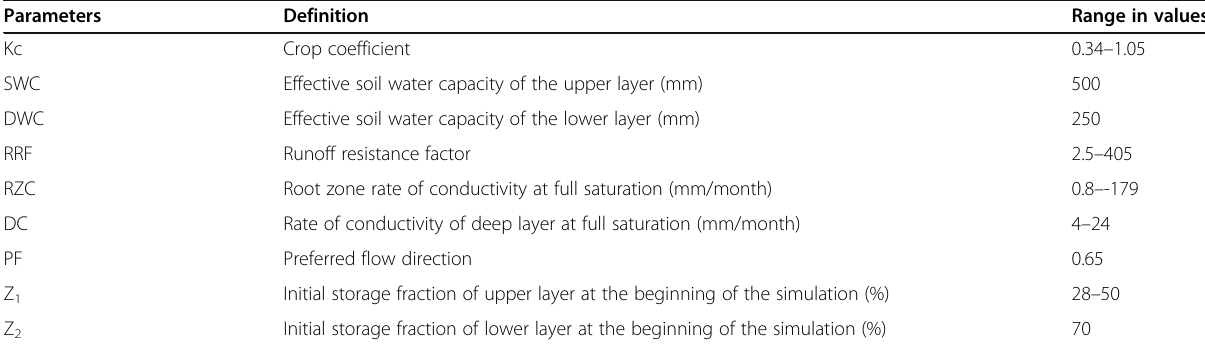
Table 3 Range of values for the estimated parameters used in the WEAP model for the Ketar River subbasin